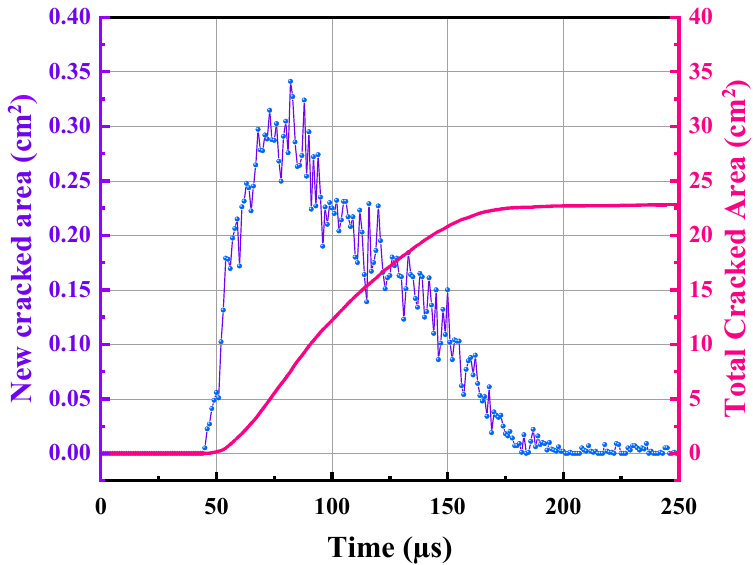
Figure 18. Temporal evolution of new cracked area and total cracked area in the granite under high-voltage electropulse.